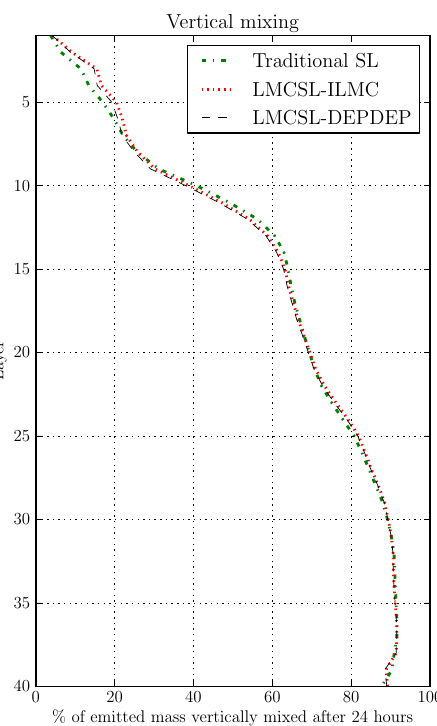
Fig. 10. Vertical mixing of passive tracers. This figure shows the amount of mass which has been mixed vertically, i.e. not present in the layer in which it was emitted. The dot-dashed (green) line is the traditional non-conserving SL scheme, the dotted (red) line is the LMCSL-3D scheme with the ILMC filter, and the dashed (black) line is the LMCSL-3D scheme with the DEPDEP filter.